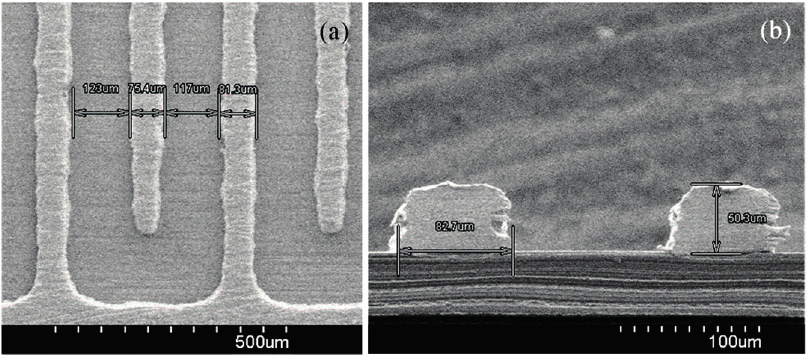
Figure 4. SEM images of the fabricated interdigitated electrode (IDE): ( a ) top view and ( b ) cross-sectional view of the